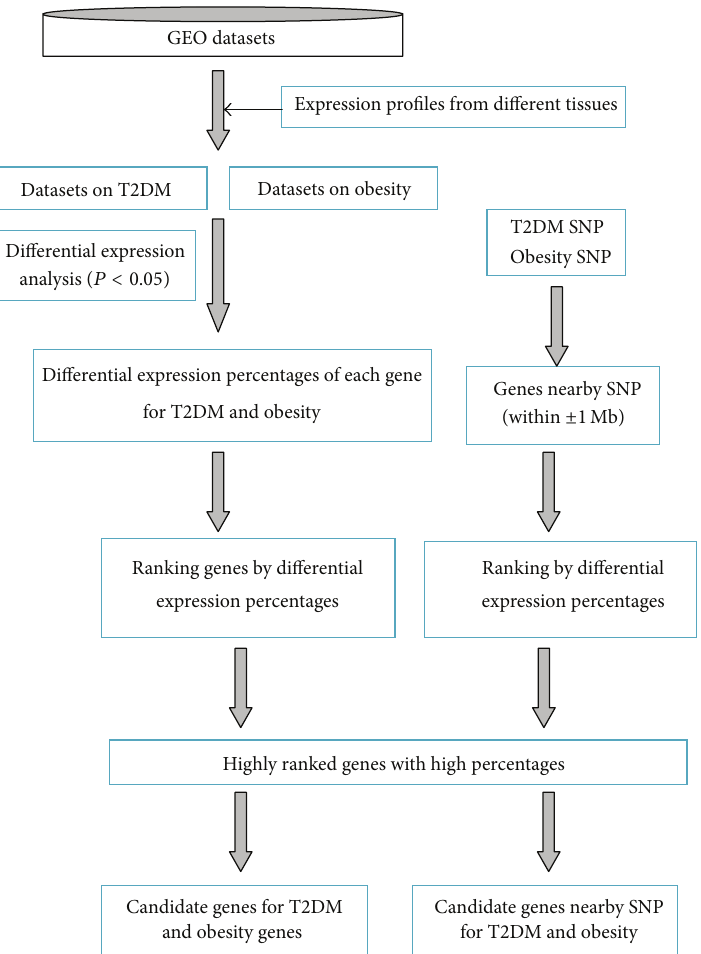
Figure 1: Overall experimental